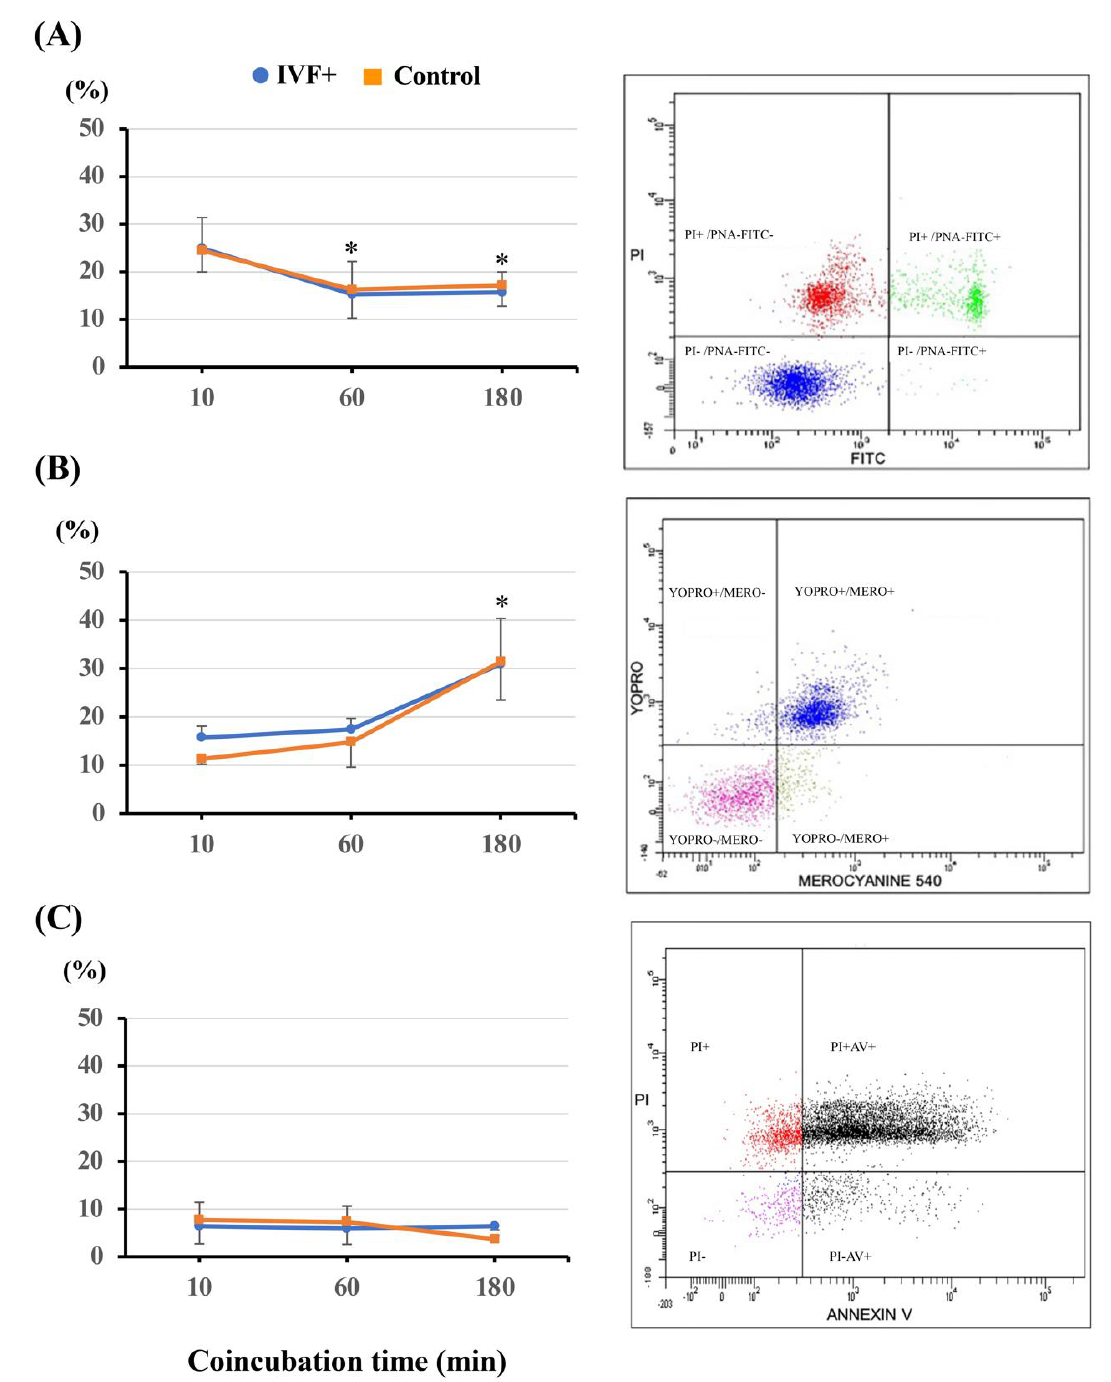
Figure 2. Effects of 1 nM melatonin addition to gamete coincubation medium (IVF+) on sperm pa-